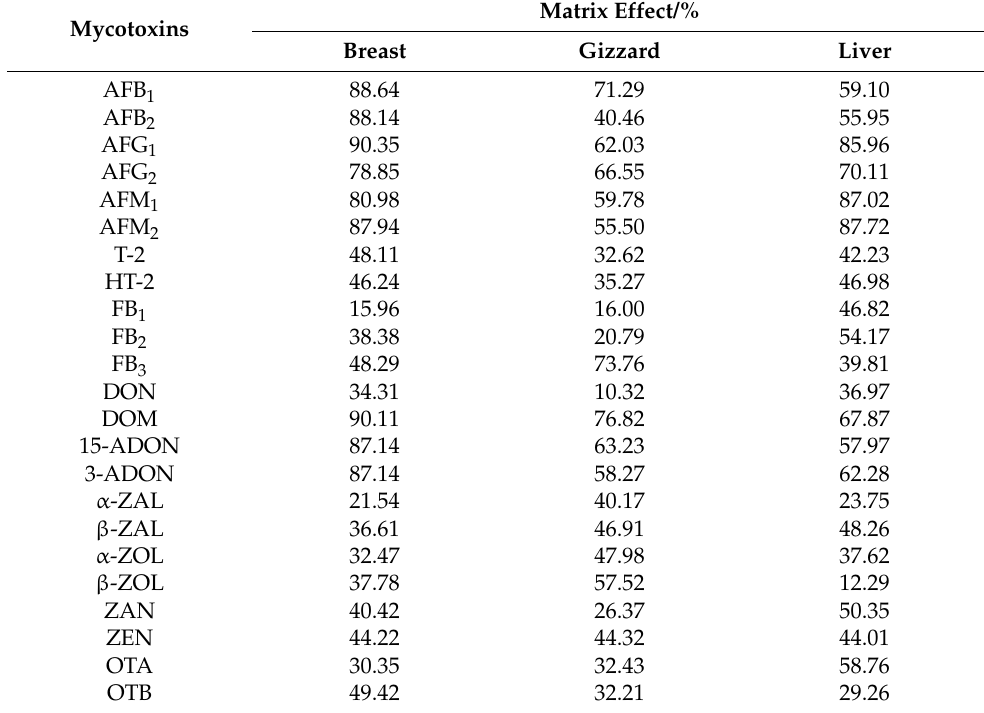
Table 3. Evaluation of matrix effect.